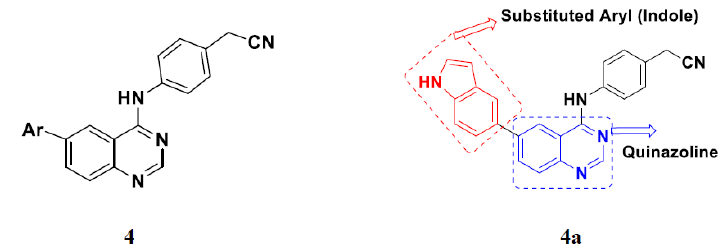
Figure 5. Structure of quinazoline-based aryl hybrids and the most promising compound 4a. Table 4. In vitro cytotoxic activities of hybrid compounds 4 ( b – e ).